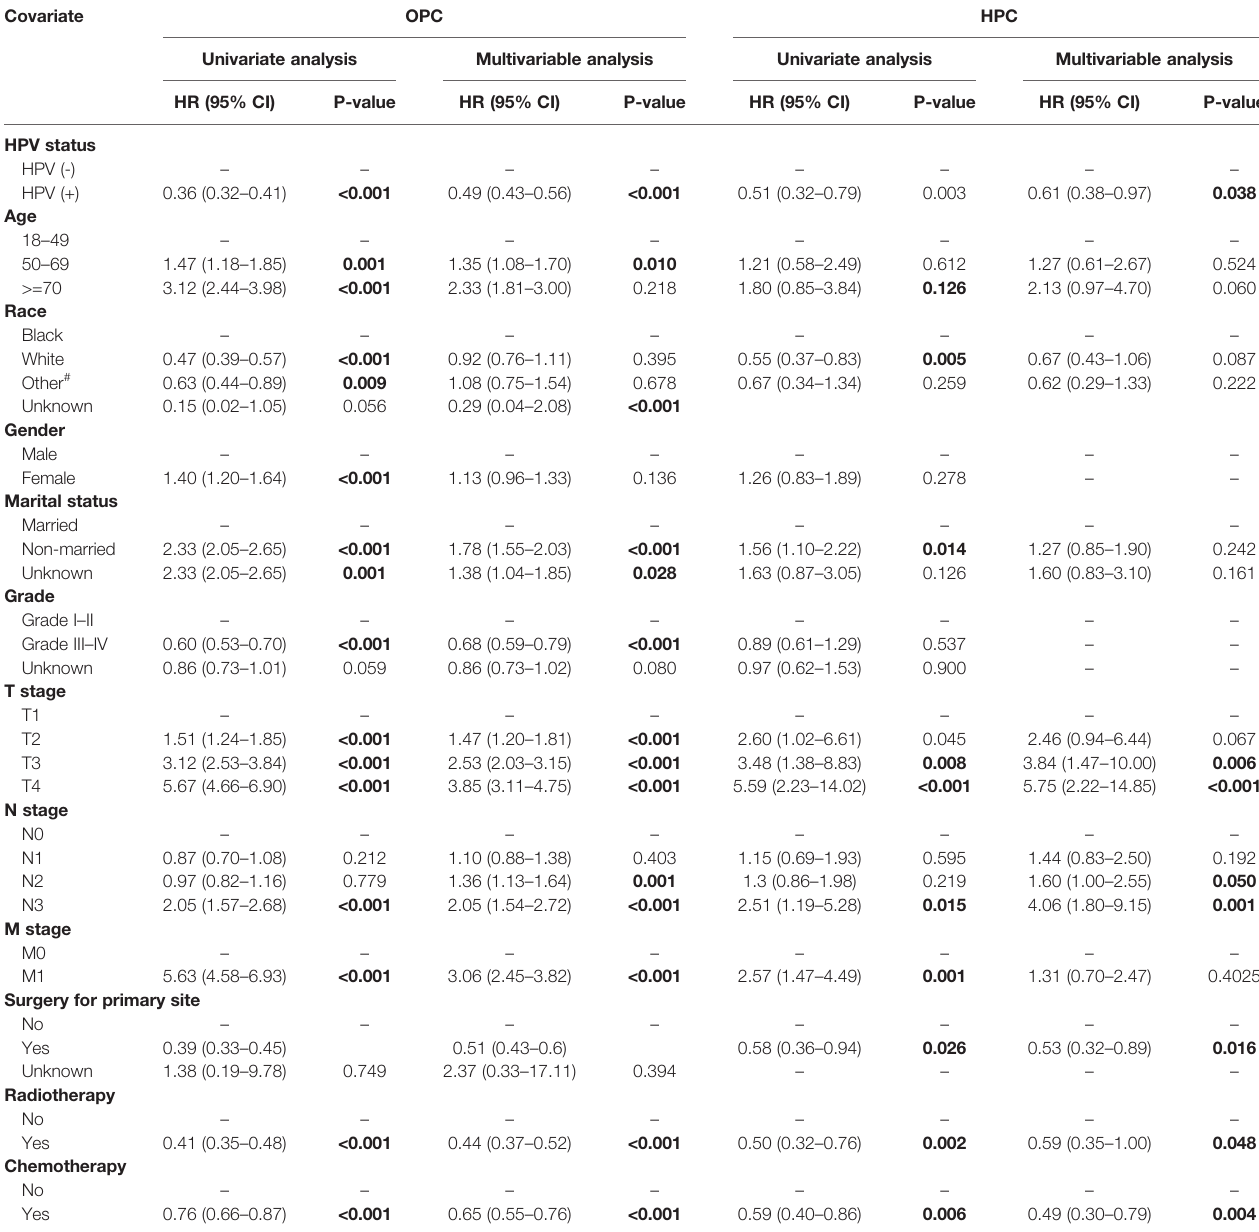
TABLE 3 | Univariate and multivariate cox analysis of the overall survival for patients with oropharyngeal carcinoma (OPC) and Hypopharyngeal carcinoma (HPC) in the training groups.